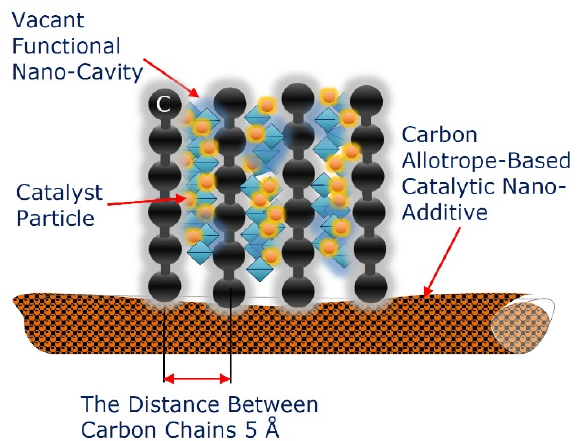
Figure 4. Schematic representation of the multiple heteroatom-doped functionalizing nanocarrier, based on the 2D-ordered linear-chain carbon-based multicavity nanomatrix, containing the vacant functional nanocavities.